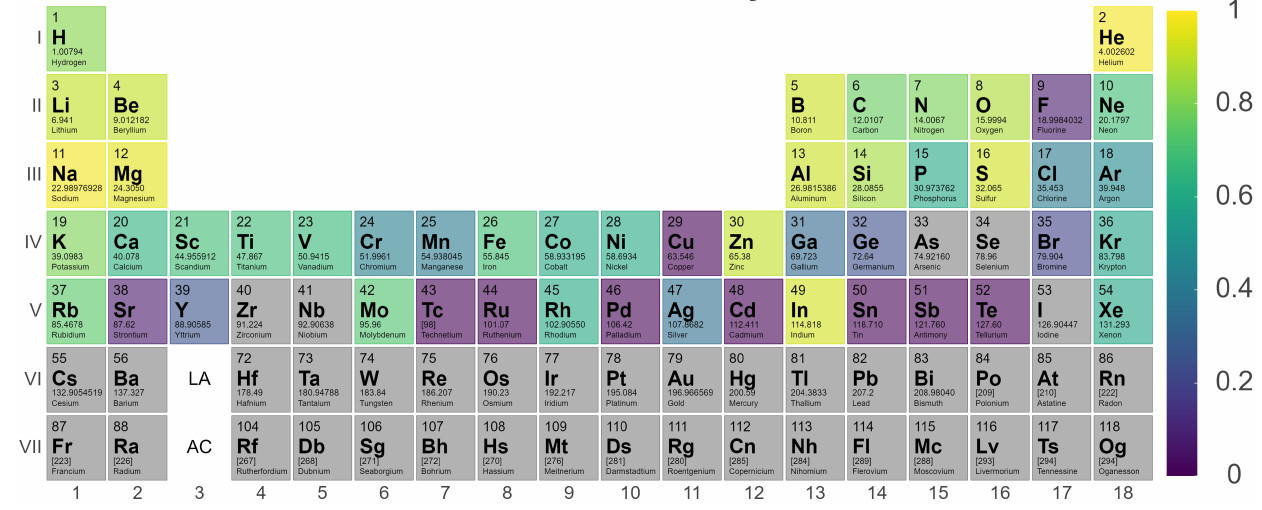
Figure 1. R 2 metric applied to modeled elements across the first five periods of the periodic table.